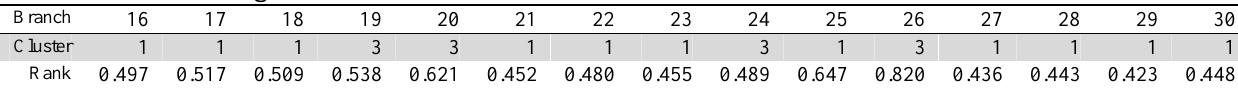
The results of ranking different banks